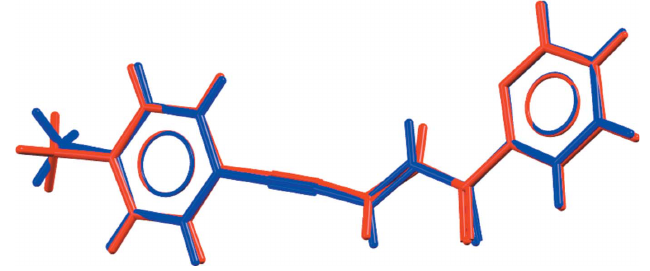
Figure 2 Conformation of the two symmetrically independent molecules in 2 (red and blue) in superimposed